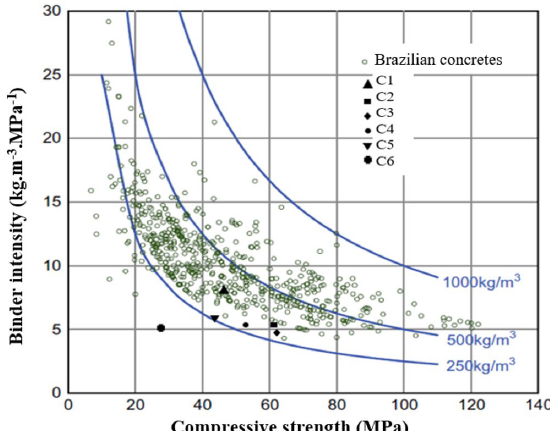
Figure 4. Binder intensity versus Compressive strength. Adapted from Damineli et al.